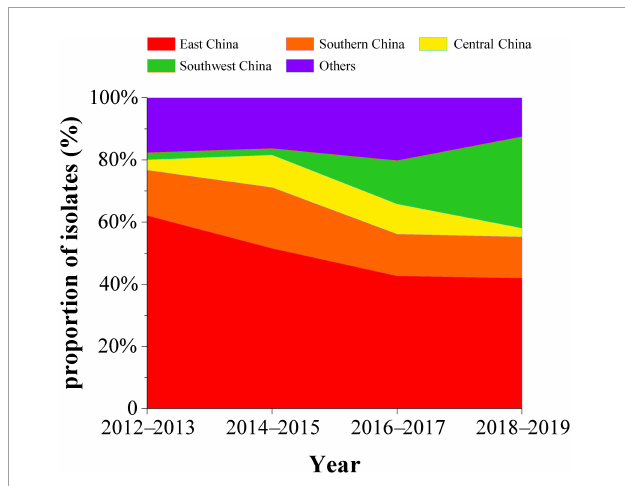
FIGURE1 Percentage of isolated H9N2 subtype avian influenza viruses by region in China, 2012–2019 (red, East China; orange, South China; yellow, Central China; green, Southwest China; purple, Other regions).